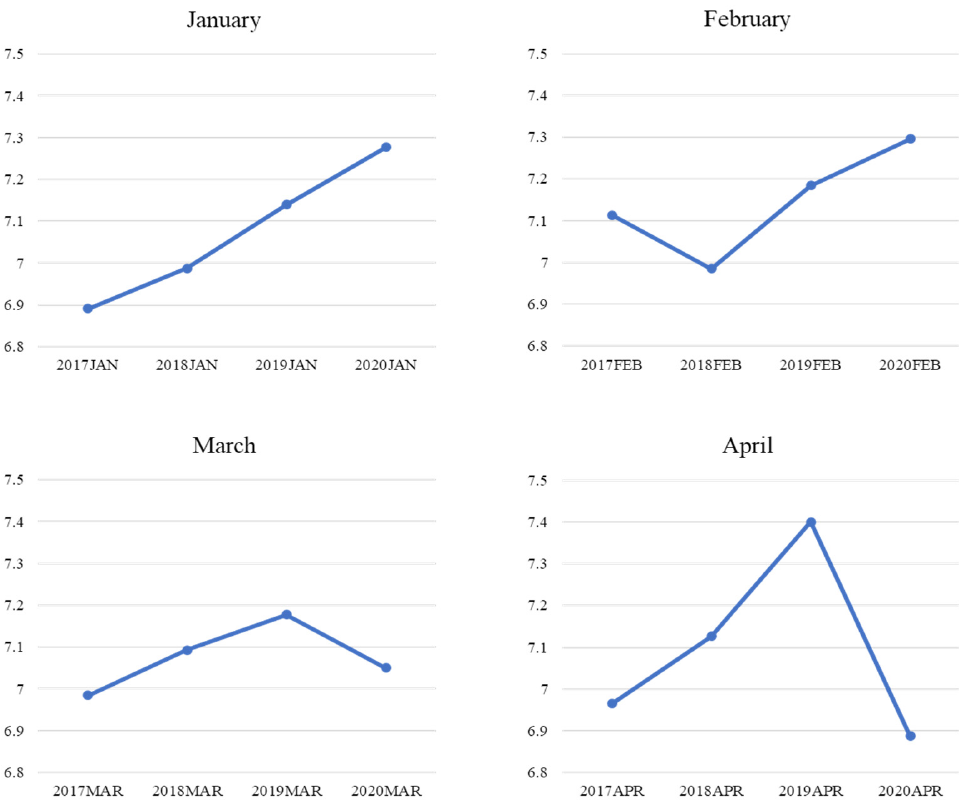
Figure 5. Mean Comparison of Negative Sentiment by Month.